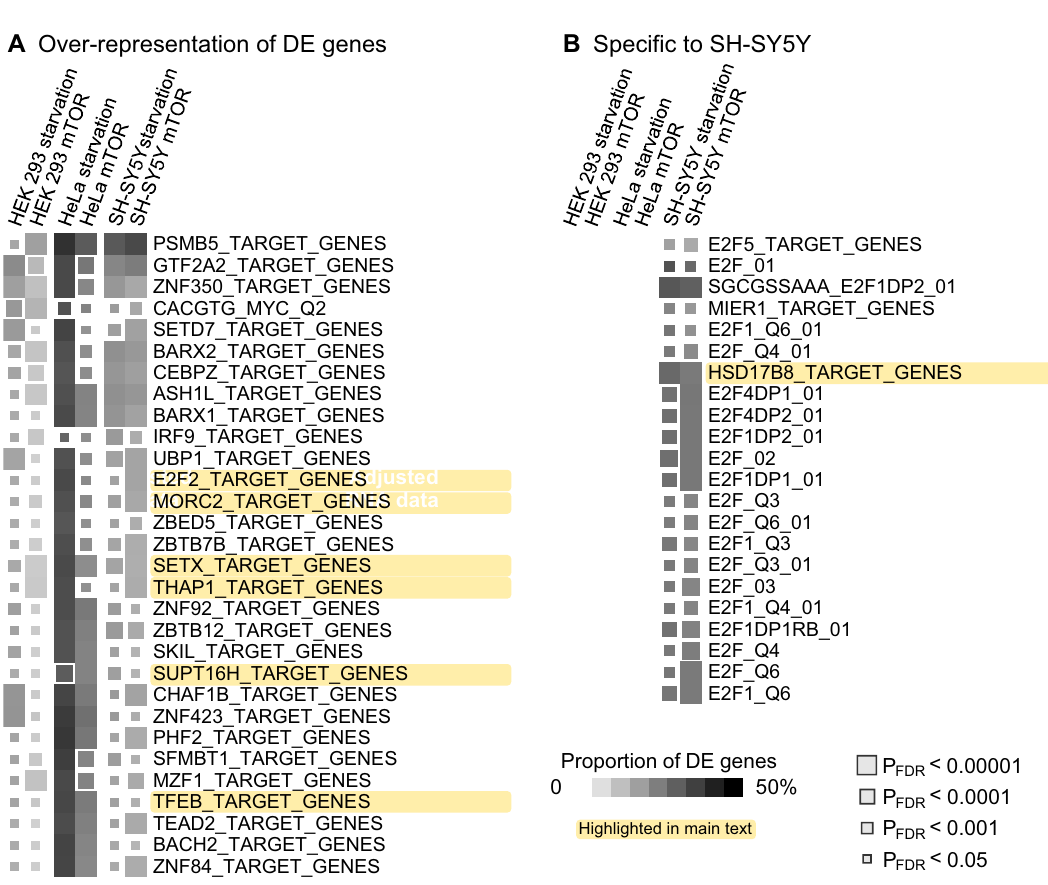
Figure 4. Enrichment of differentially expressed genes in transcription factor target (TFT) sets. ( A ) Over- representation analysis of DE genes. Pathways that produced a significant signal (P FDR < 0.05) in at least one experiment are shown. ( B ) DE enrichment within TFT sets in SH-SY5Y cells but not in other